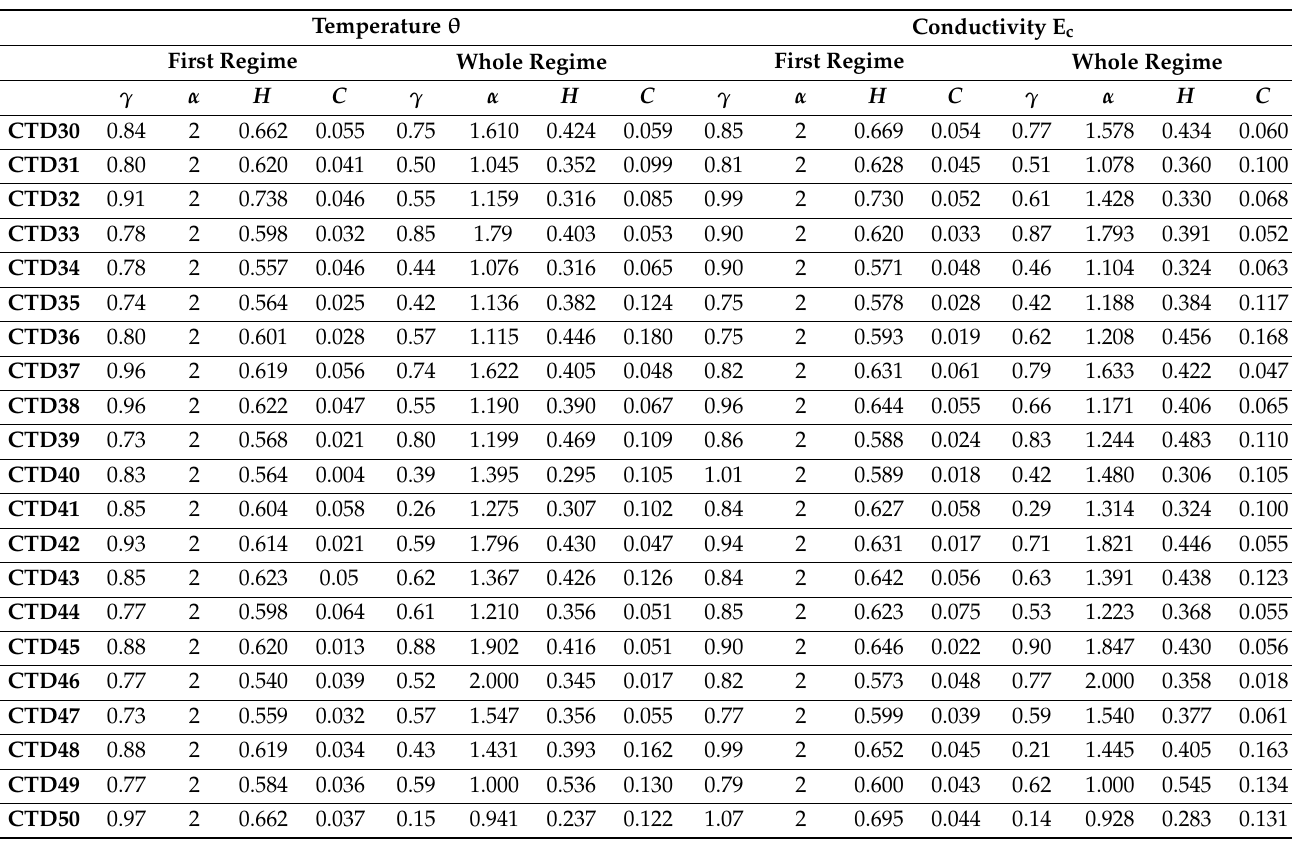
Figure 4. Logarithmic plots of the variance for ( a ) temperature, θ, (orange dots) and ( b ) conductivity, E c , (dark green dots) with respect to the lag time for the CTD30 time series. The variance for both temperature and conductivity has been fitted by Equation (1). In each figure, the short black solid line represents the best fit for short times (first regime), and the long one the best fit for long times (whole regime). Notice that Δ (s) refers to the unit of time in seconds. Table 2. γ , α, H , and C parameters of the temperature and conductivity for both first and whole regimes (short and long times) and for each one of the recorded CTD time series. Notice that for short times the alpha index is 2.